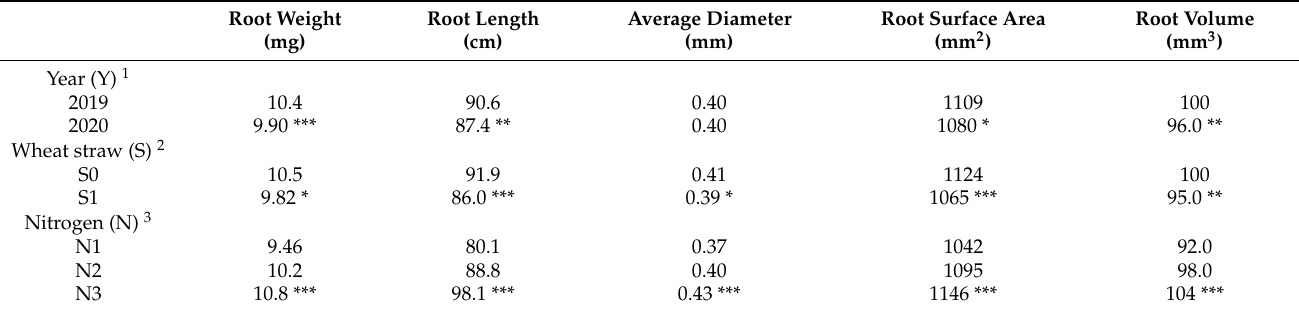
Table 5. Root morphological characteristics at 35 days after sowing as affected by wheat straw